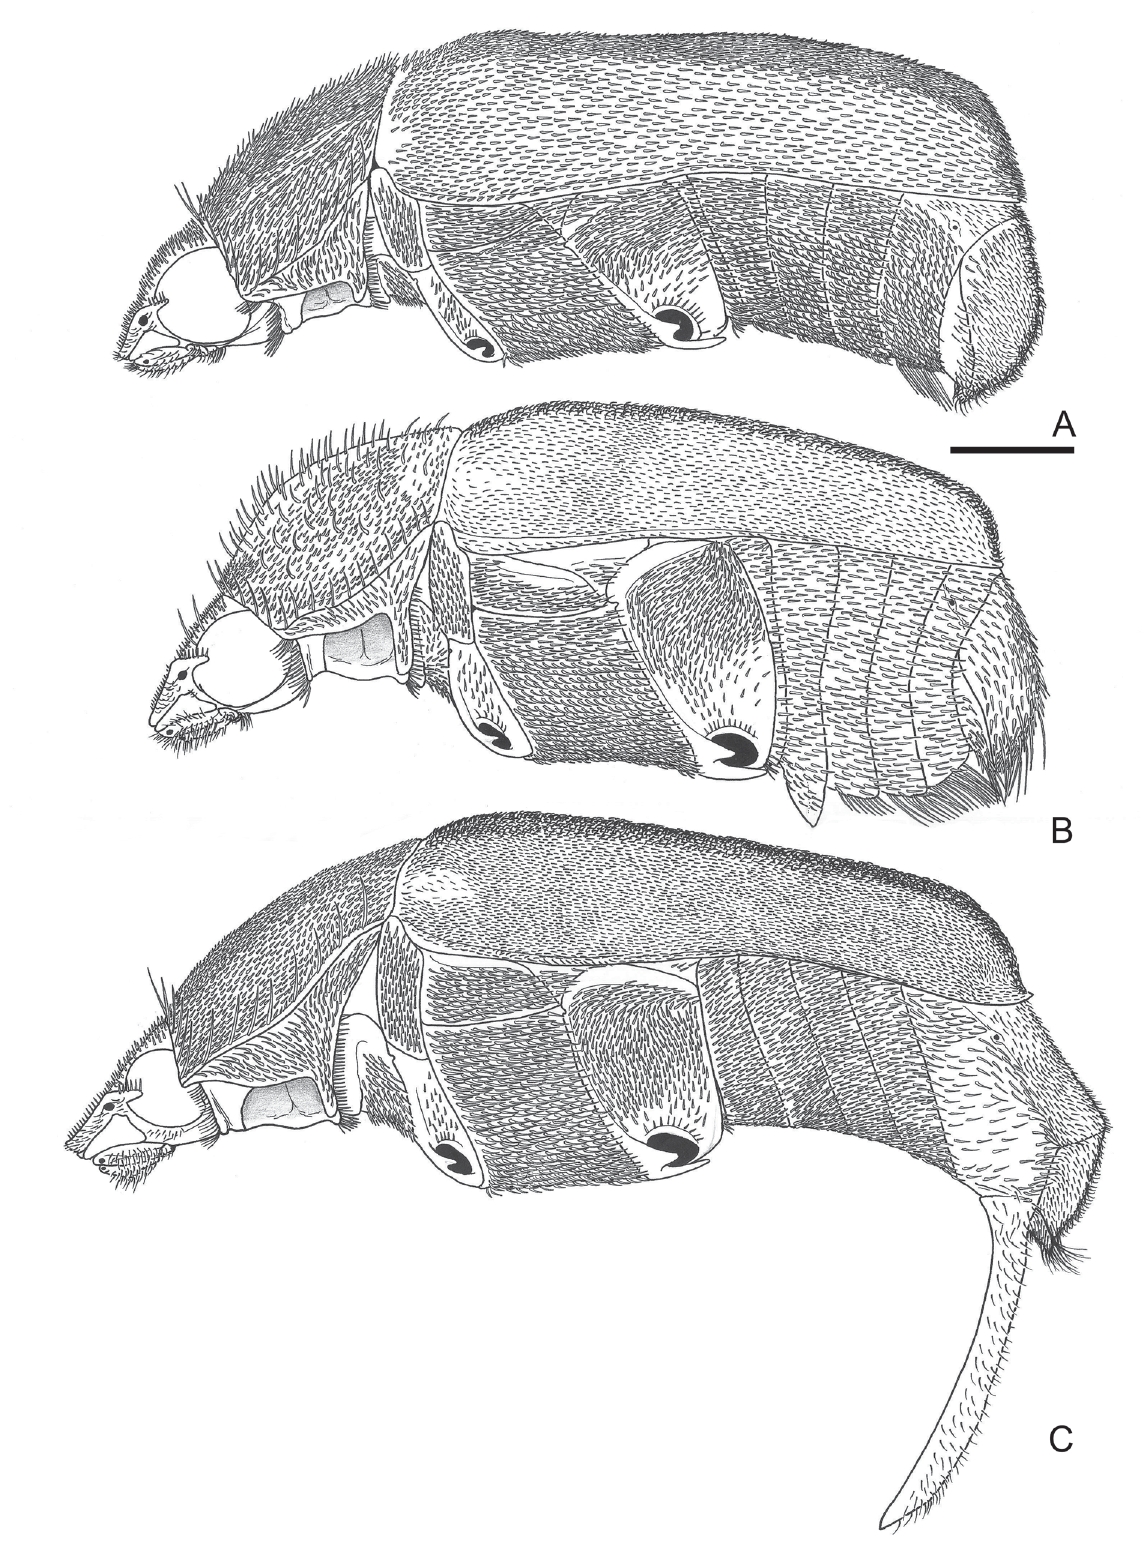
Fig. 15. Schizochelus Blanchard, 1850, ♂, habitus, lateral (without some appendages). A . Schizochelus flavescens Blanchard, 1850. B . Schizochelus bicoloripes Blanchard, 1850. C . Schizochelus mirabilis (Moser, 1921) comb. nov. Scale bar = 1